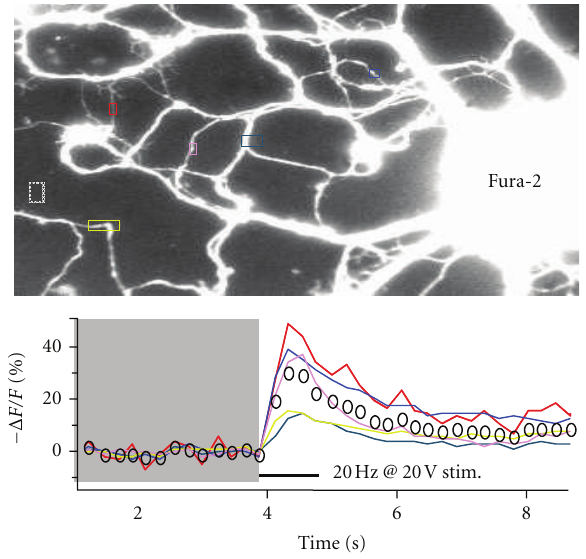
Figure 4: To confirm the viability of neurons transfected with BDNF-pH and their responsiveness to extracellular field stimula- tion, Ca 2+ imaging was performed in neurons labeled with fura- 2 AM. Upon electrical stimulation through field Pt wires, Ca 2+ transiently increased in several dendrites. The graph shows the time course of background-subtracted delta F/F 0 of 380 nm-excited fura- 2 fluorescence intensity (510nm emission) from the colored ROIs shown in the image. Images taken at